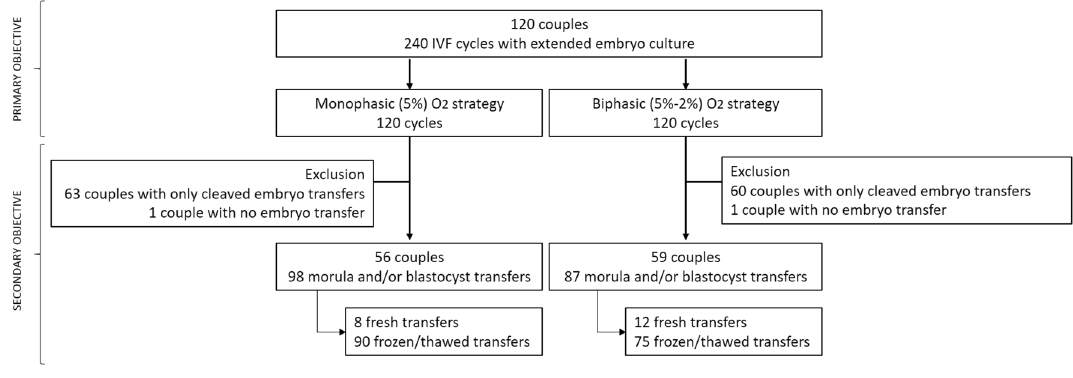
Figure 1. Study flowchart. IVF: in vitro